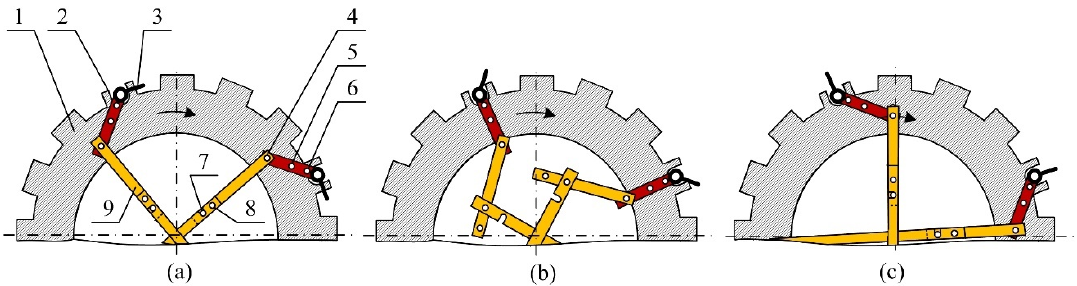
Figure 2. Principle of the spike tires without pins and wire strands: ( a ) spikes in the base position, ( b ) change of spike positions, and ( c ) spikes in the protruded position. 1—tire; 2—groove in tire; 3—spike segment; 4, 8—hole for pin; 5—hole for pin of the control wire strand; 6—hole for pin of the carrier wire strand; 7—hole for safety screw; 9—control lever mechanism.